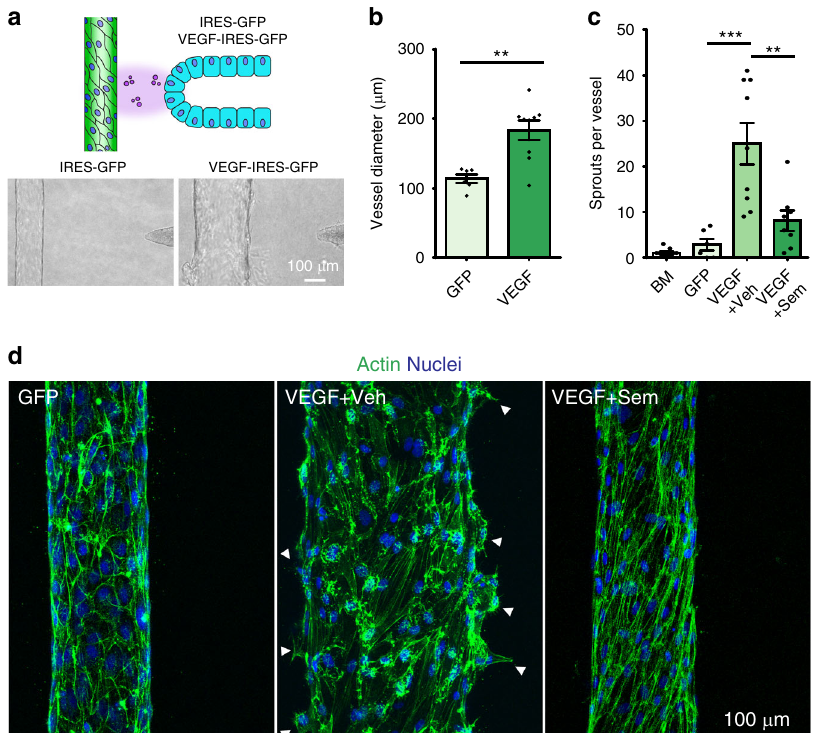
Fig. 2 Vascular morphogenesis driven by mammary paracrine signaling. a Cartoon of co-culture paracrine experimental setup. MCF10A cells expressing IRES-GFP or VEGF-IRES-GFP were seeded into the duct channels adjacent to an endothelialized vessel. Phase-contrast images of vessels with control (left) and VEGF expressing ducts (right) after two days in co-culture. b Quanti fi cation of endothelial vessel diameter after three days of culture with either GFP or VEGF expressing MCF10A cells ( n = 6, 9 vessels examined across three independent experiments; two-tailed, unpaired Student ’ s t test ** p = 0.0019). c Quanti fi cation of sprout number per endothelial vessel after three days of culture with acellular basal assay medium (BM), GFP expressing ducts (GFP), or VEGF expressing ducts in which DMSO (VEGF + Veh) or 10 µ M Semaxanib (VEGF + Sem) was delivered to the vasculature. ( n = 9, 6, 9, 8 vessels examined across three independent experiments; one-way ANOVA with Bonferroni post test *** P = 0.000014, ** P = 0.0011). d Maximum intensity projection micrographs of tissue base to medial section of endothelial vessels co-cultured with GFP or VEGF ducts and treated with DMSO or 10 µ M Semaxanib; phalloidin (green) and DAPI (blue). Arrows indicate nascent angiogenic sprouts. For all plots, values mean ± s.e.m and all images are representative of at least three independent experiments. Source Data are provided as a Source Data fi